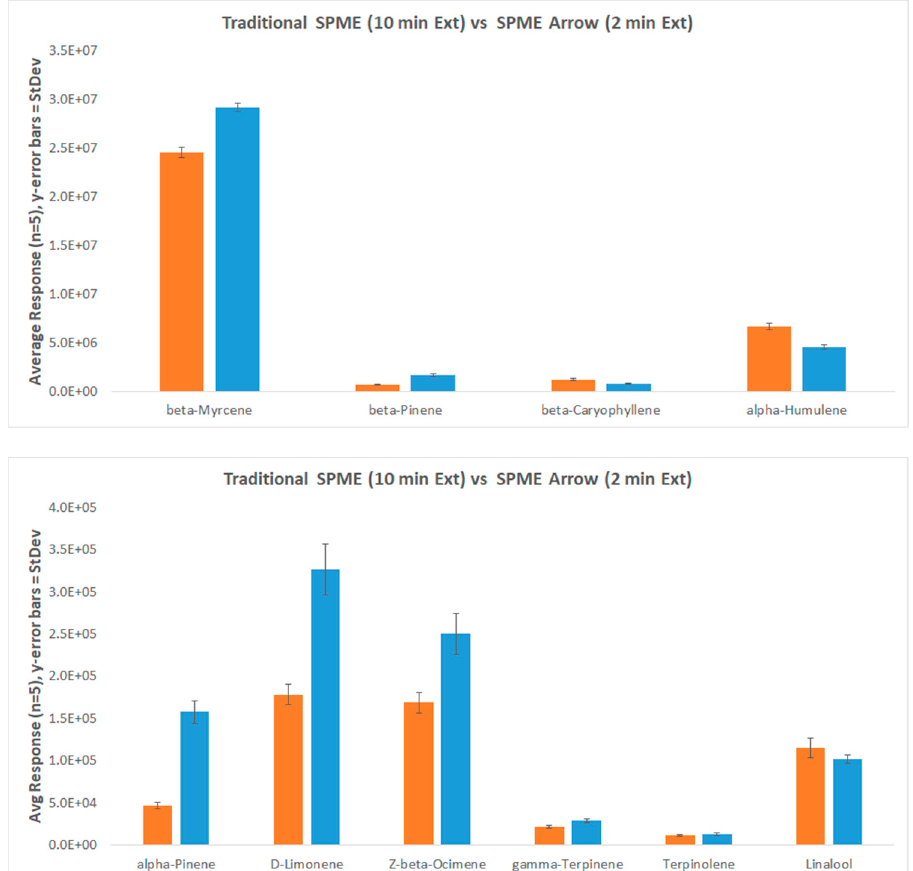
Figure 7. Extraction of VOCs in cannabis-related applications. Comparison of the traditional SPME fiber vs. SPME Arrow. Acquired on Agilent 7890B/5977B GC-MS.